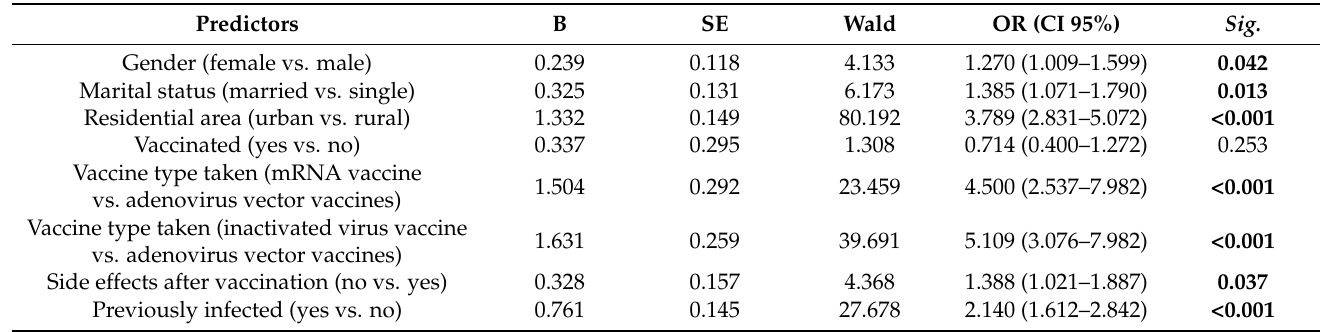
Table 6. Univariate regression analysis of the predictors of COVID-19 vaccine BD acceptance among study participants.